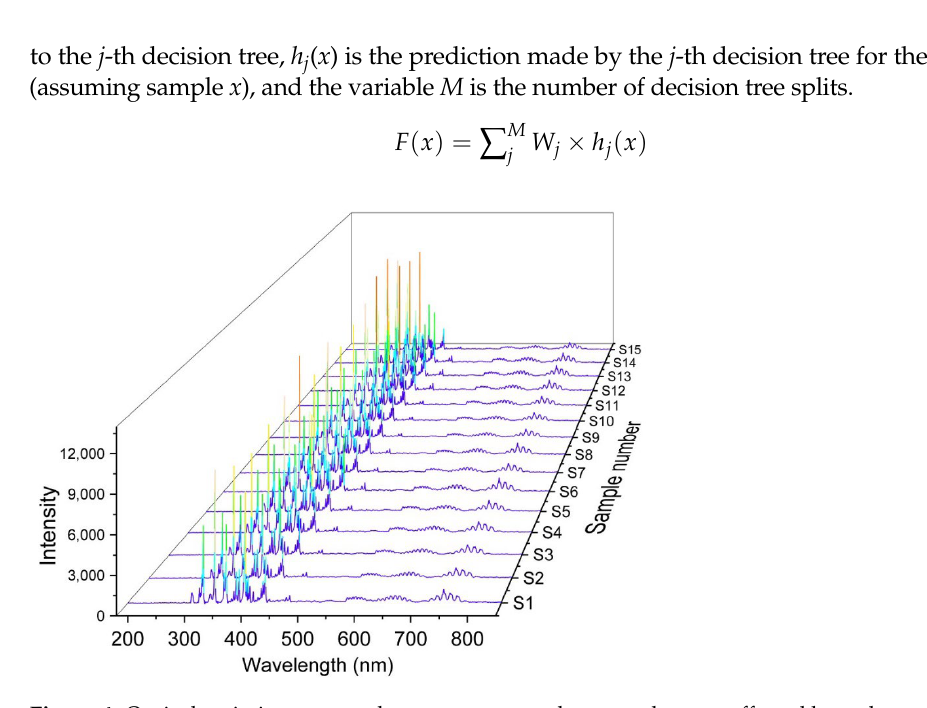
Figure 4. Optical emission spectra that were measured separately were affected by pulse parame- ters. Spectrum data were integrated with the plasma’s time (0–30 min) in S1–S15.